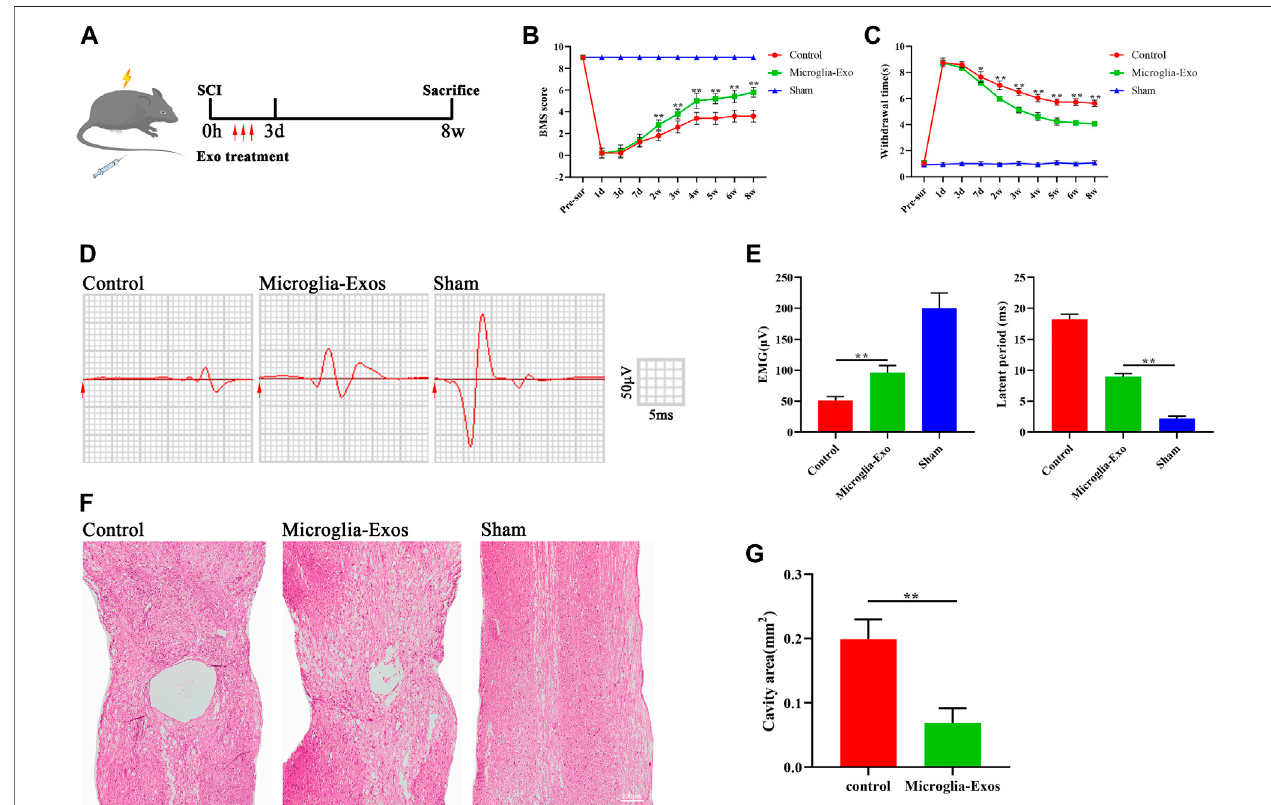
FIGURE 2 | Microglia-Exos improved neurological function after SCI . (A) Schematic depiction of experiment procedures. (B) BMS scores in sham, control, and microglia-Exo – treated groups at different time points post-SCI. N (cid:1) 5 per group. (C) Hind paw withdrawal times of sham, control, and microglia-Exo – treated groups at different time points post-SCI. N (cid:1) 5 per group. (D) Neuroelectrophysiology analysis of sham, control, and microglia-Exo – treated groups at 56 days post-SCI. (E) Quanti fi cation of motor evoked potential (MEP) and latent period in (D) . N (cid:1) 5 per group. (F) Representative images of hematoxylin-eosin (HE) staining of sham, control, and Microglia-Exo – treated groups. Scale bar:200 μ m. (G) Quanti fi cation ofcavityareaof (F) .N (cid:1) 5per group. Dataarepresentedasthe mean ± SD. * p < 0.05, ** p < 0.01.